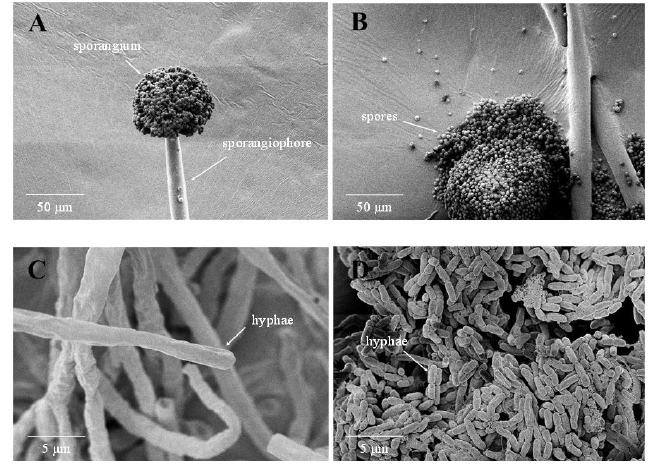
Figure 4. Scanning electron micrographs of Aspergillus niger cultured on PDB for 3 days. ( A – C ) Con- trol; ( D ) treated with cyclosporin A (CsA) at 1 mg/L.